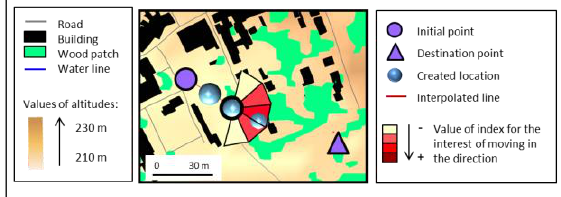
Figure 4. The interest function: it takes into account the cost value of landscape elements for movement. In that example, half a circle represents the surroundings of the agent. It is divided in 5 equal sections and its main direction is towards the destination. The more interesting the section is, the redder it is.